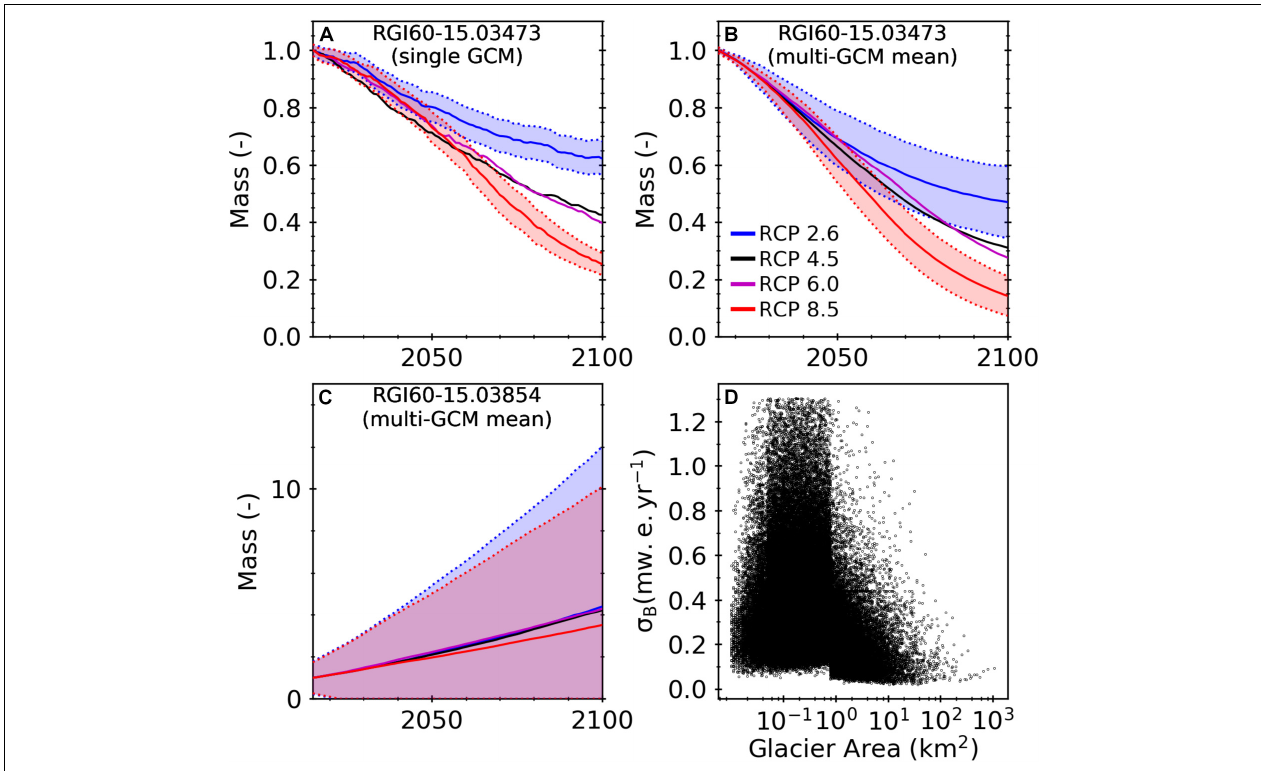
FIGURE 10 | (A–C) Examples of the normalized mass remaining from 2015 to 2100, relative to 2015, for various RCP scenarios for a large (61 km 2 ) glacier (A,B) and a small (0.4 km 2 ) glacier (C) showing the uncertainty for RCP 2.6 and RCP 8.5 (shaded colors) associated with the model parameters and GCMs for various RCP scenarios, and (D) the uncertainty associated with the mass balance data ( σ B ) used for calibration (Shean et al., 2020) versus glacier